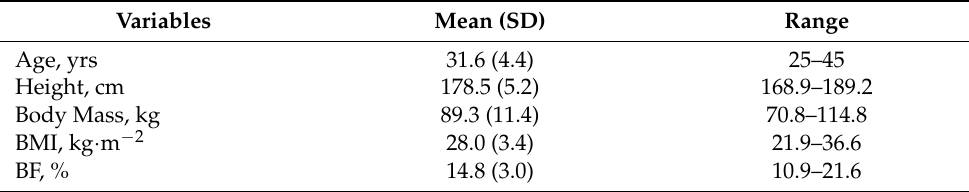
Table 1. Participant characteristics at baseline, n =